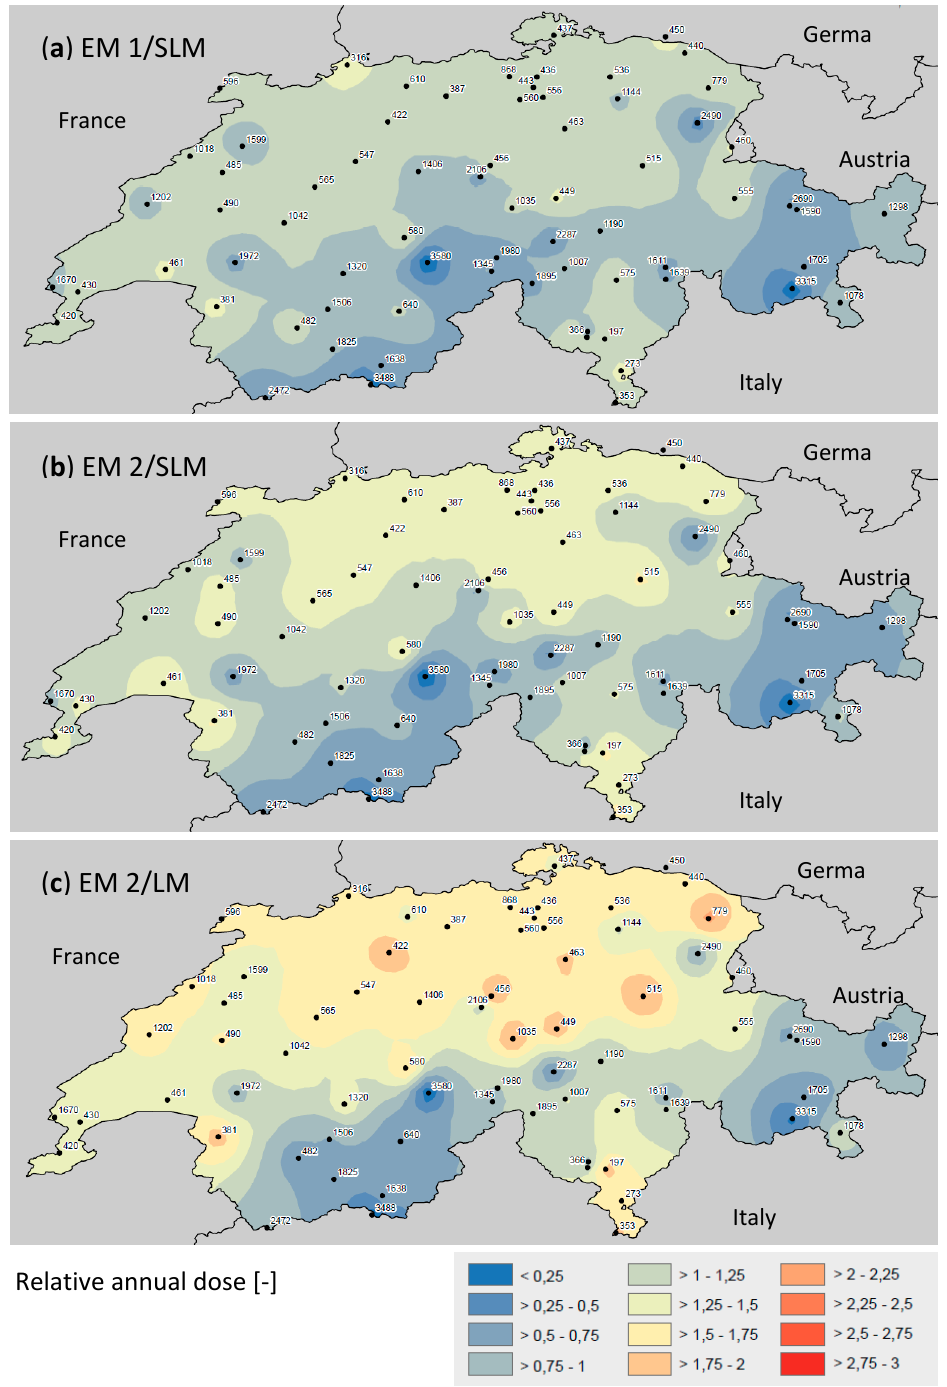
Figure 4 . Relative annual dose based on different combinations of exposure models (EM 1 and EM 2) and logistic dose–response decay models (LM and SLM). ( a ): EM1 combined with SLM, ( b ): EM 2 combined with SLM, and ( c ): EM 2 combined with LM. Reference location: Uppsala, Sweden.